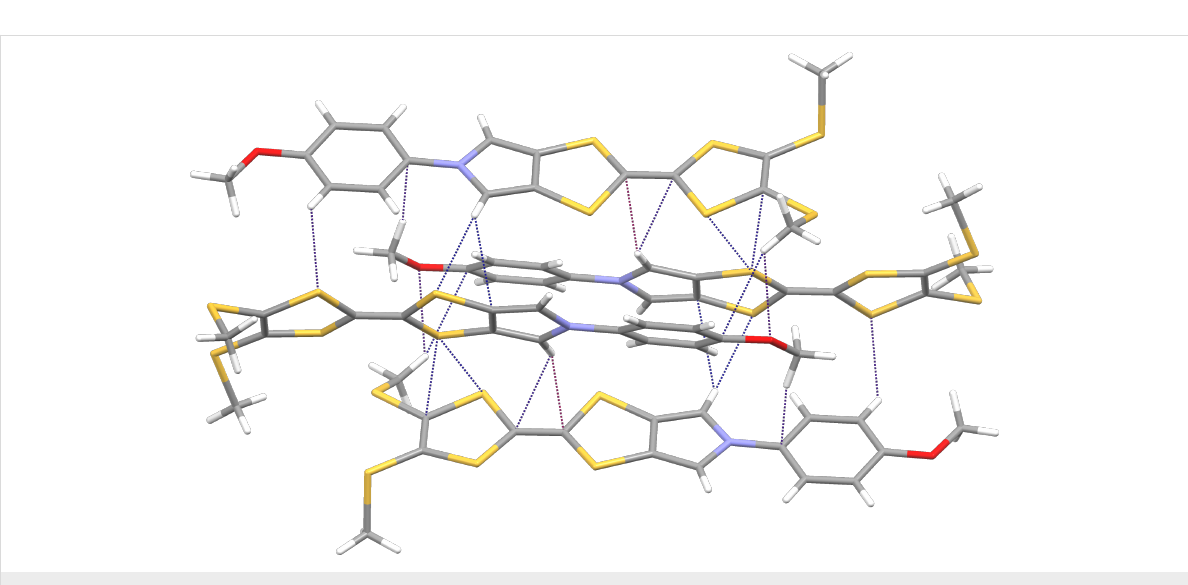
Figure 6: Crystal packing of 4b showing a group of four molecules interconnected by multiple weak hydrogen bonds, C–H··· π , and S···S close